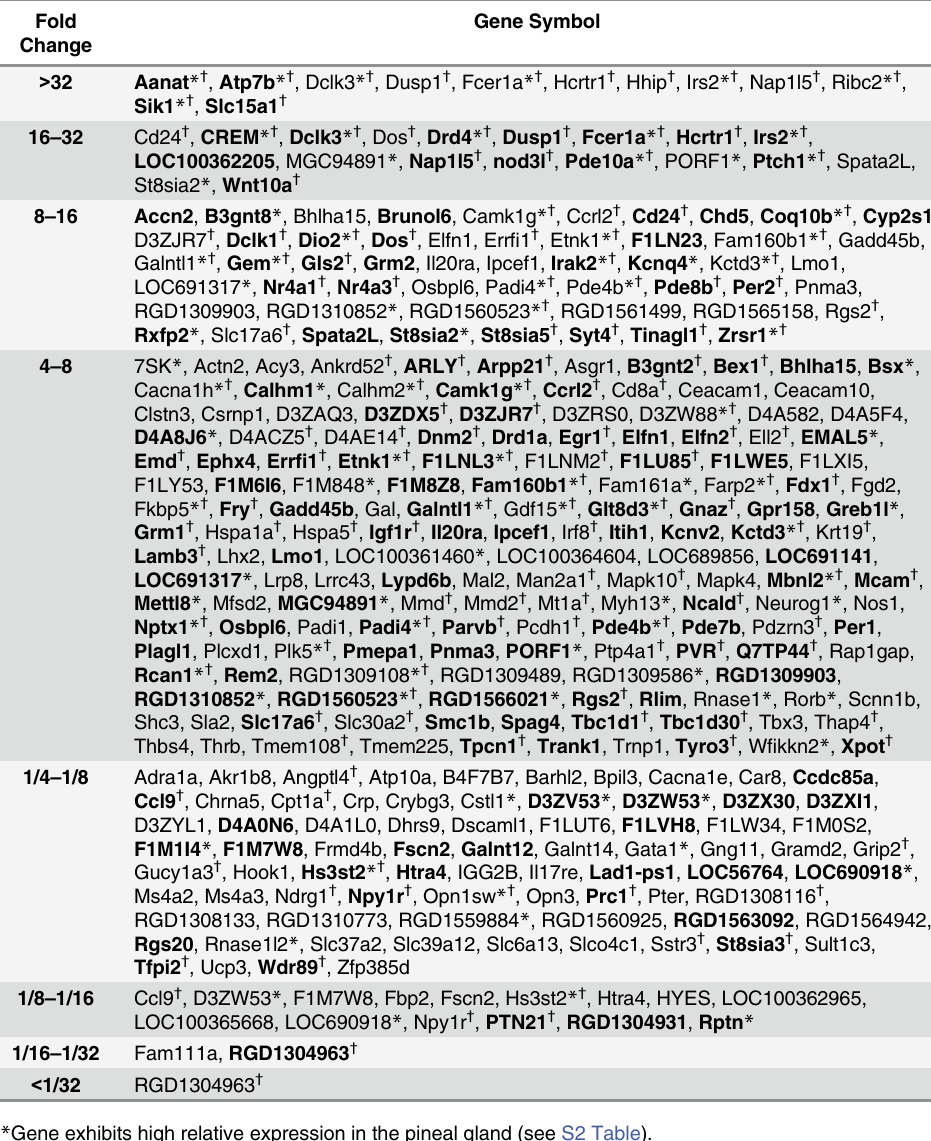
Table 1. Genes significantly differentially expressed in the pineal gland on a night/day basis in Con- trol and/or Sham groups, in vivo (adjusted-p < 0.001). Genes that exhibit strong differential expression in both are listed in bold (genes are classified by the least-extreme fold change across the two analyses). Note that some genes are listed twice if the fold changes of the two analyses fall in different intervals. In the SCGX and DCN groups, none of the genes displayed in this table exhibited night/day differential expression at this level (adjusted p < 0.001, FC > 4 in either direction). A complete list of all genes with fold changes, p-values, and normalized expression estimates is available in the SI (S1